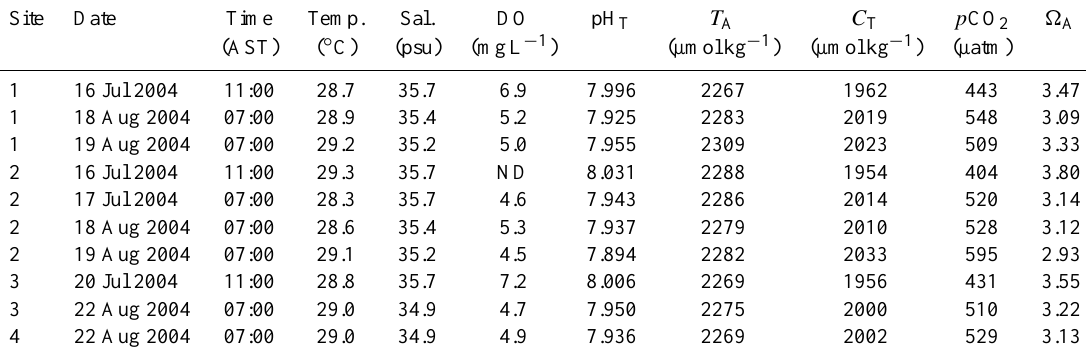
Table 5. Long bay reef